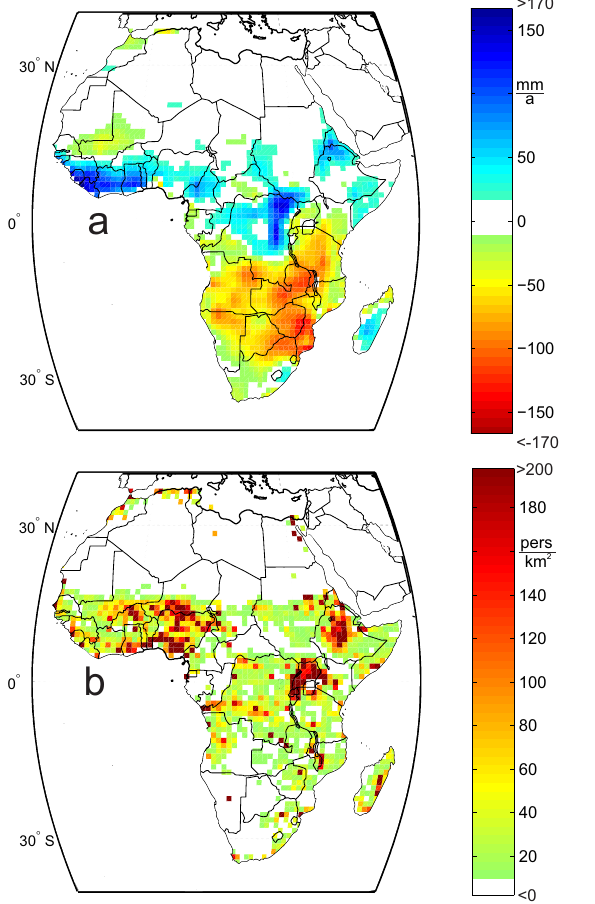
Fig. 11. Projected burned area fraction across Africa calculated from model VC according to the climate and population develop- ment relating to SRES storyline B1. Displayed are the average burned fraction from 2050 to 2060 (a) and the average of the years 2050 to 2060 minus the average of the years 1990 to 2000 (b)